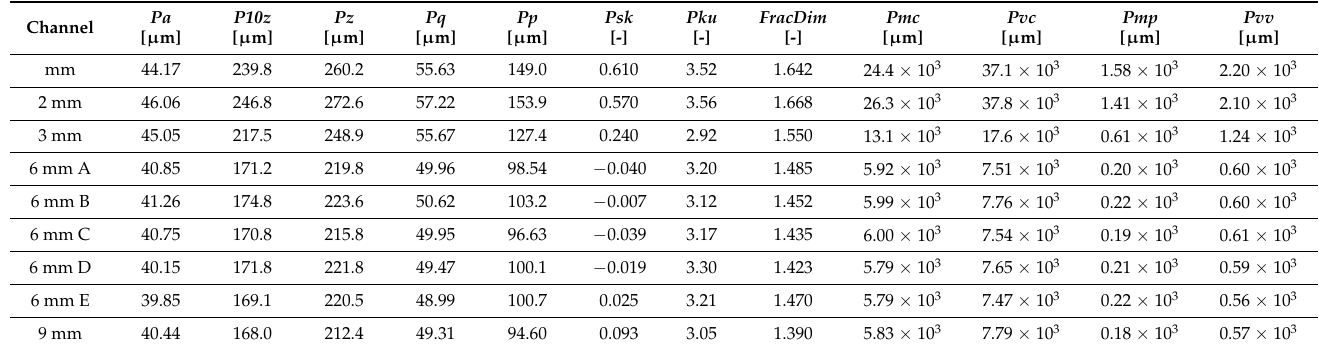
Table 4. Calculated average profile parameters for all nine investigated